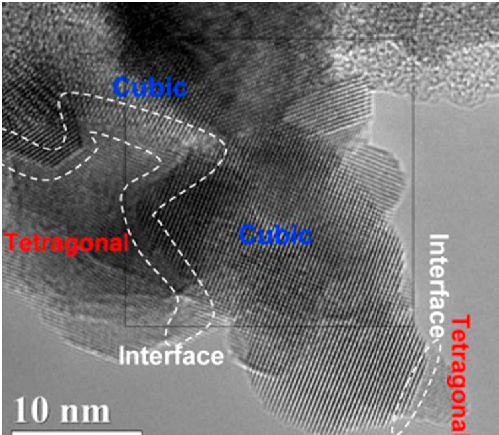
Figure 2. Cubic–tetragonal interfaces in ceria-zirconia prepared by a mixed-solvent solvothermal synthesis [43]. Reprinted from Yang, Z.; Hu, W.; Zhang, N.; Li, Y.; Liao, Y. Facile synthesis of ceria– zirconia solid solutions with cubic–tetragonal interfaces and their enhanced catalytic performance in diesel soot oxidation. J. Catal. 2019 , 377 , 98–109, with permission from